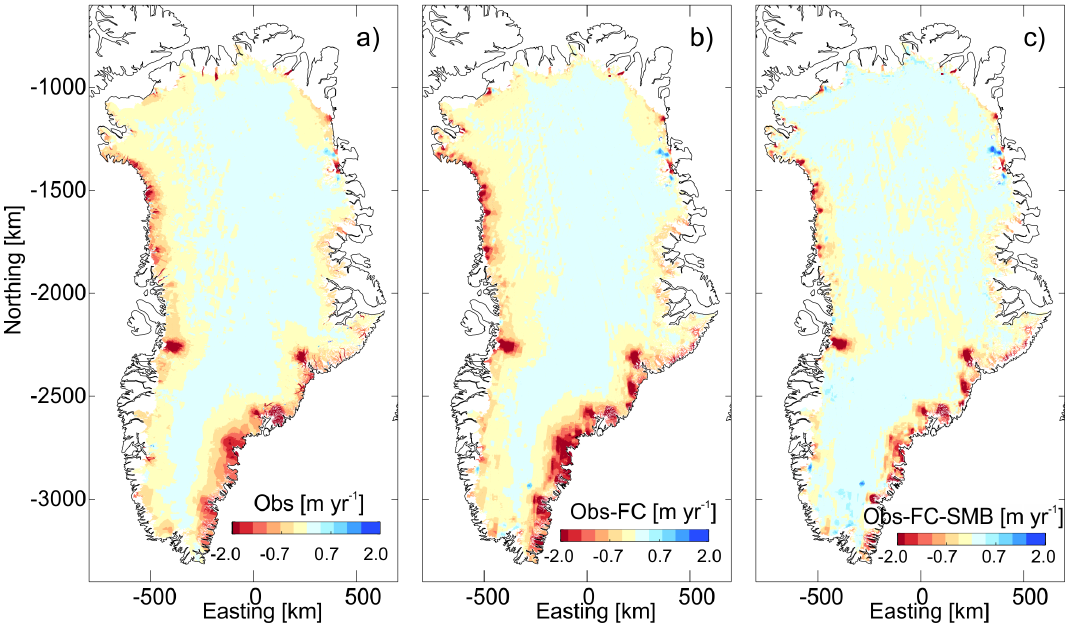
Figure 7. Observed d H /d t from ICESat (a) ; observed d H /d t corrected for ˙ H fc (b) ; and observed d H /d t corrected for both ˙ H fc and ˙ H smb , in effect showing ˙ H dyn